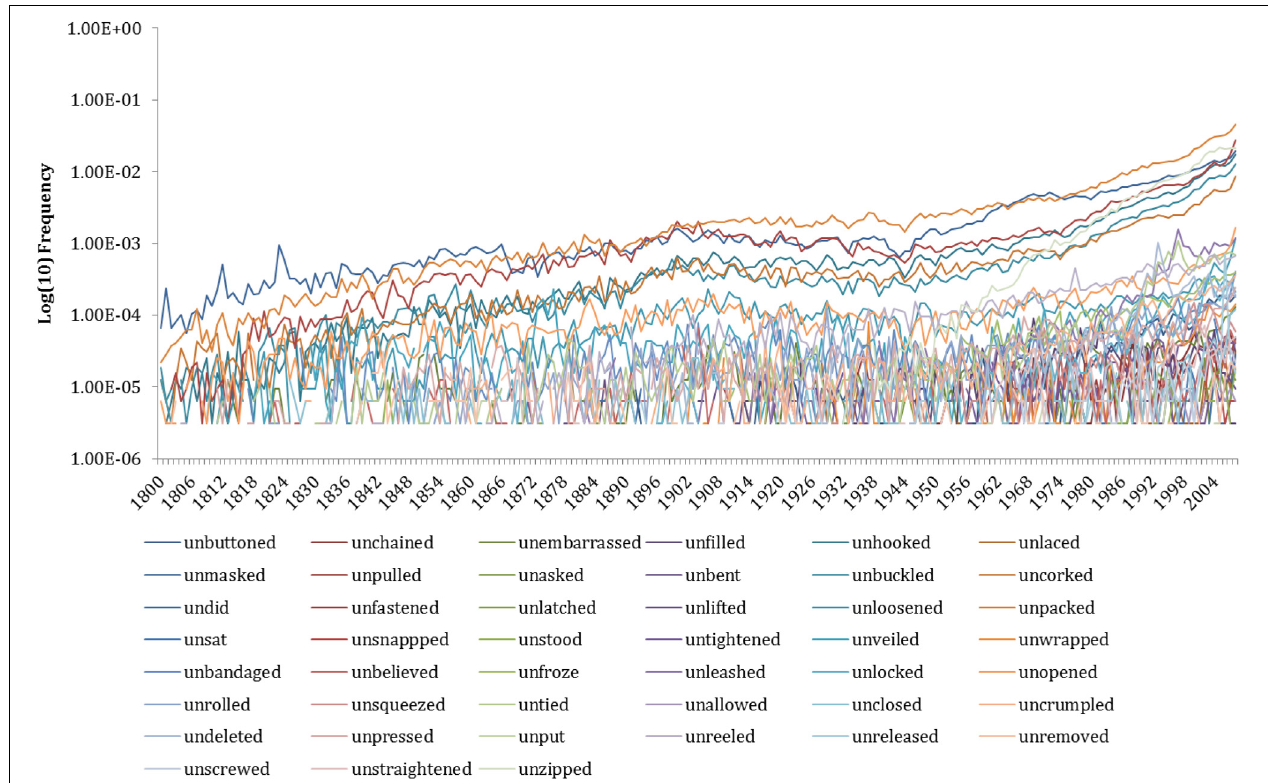
FIGURE A3 | Historical trends of un-forms ( N = 828,813) item analysis on raw frequency.